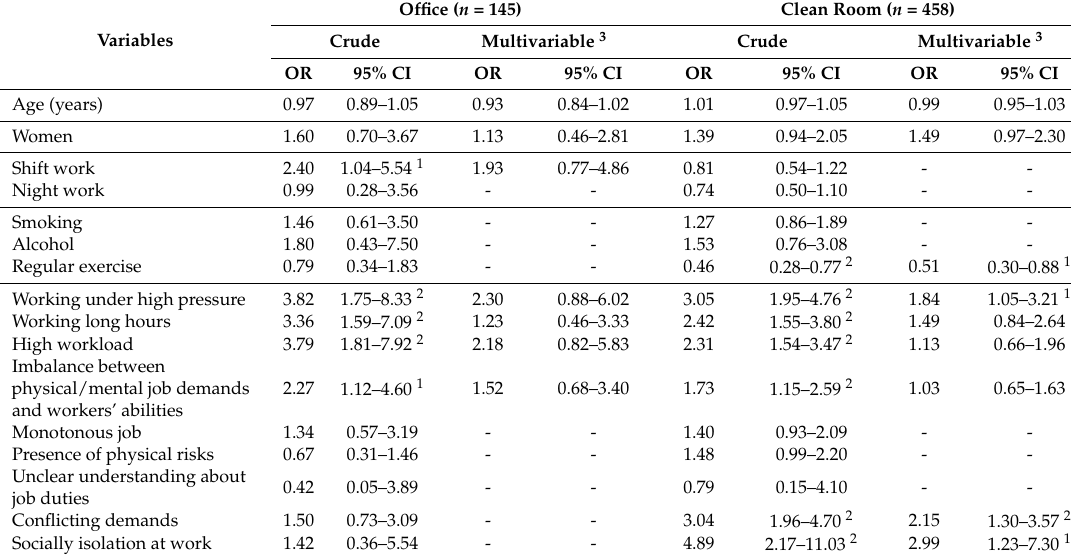
Table 6. Univariate and multivariate logistic regression analysis of factors influencing emotional symptoms, stratified by work